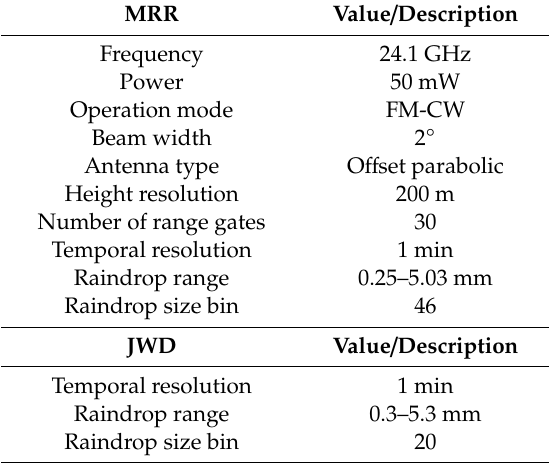
Table 1. Characteristics of the micro rain radar (MRR) and Joss-Waldvogel disdrometer (JWD) used in this study.